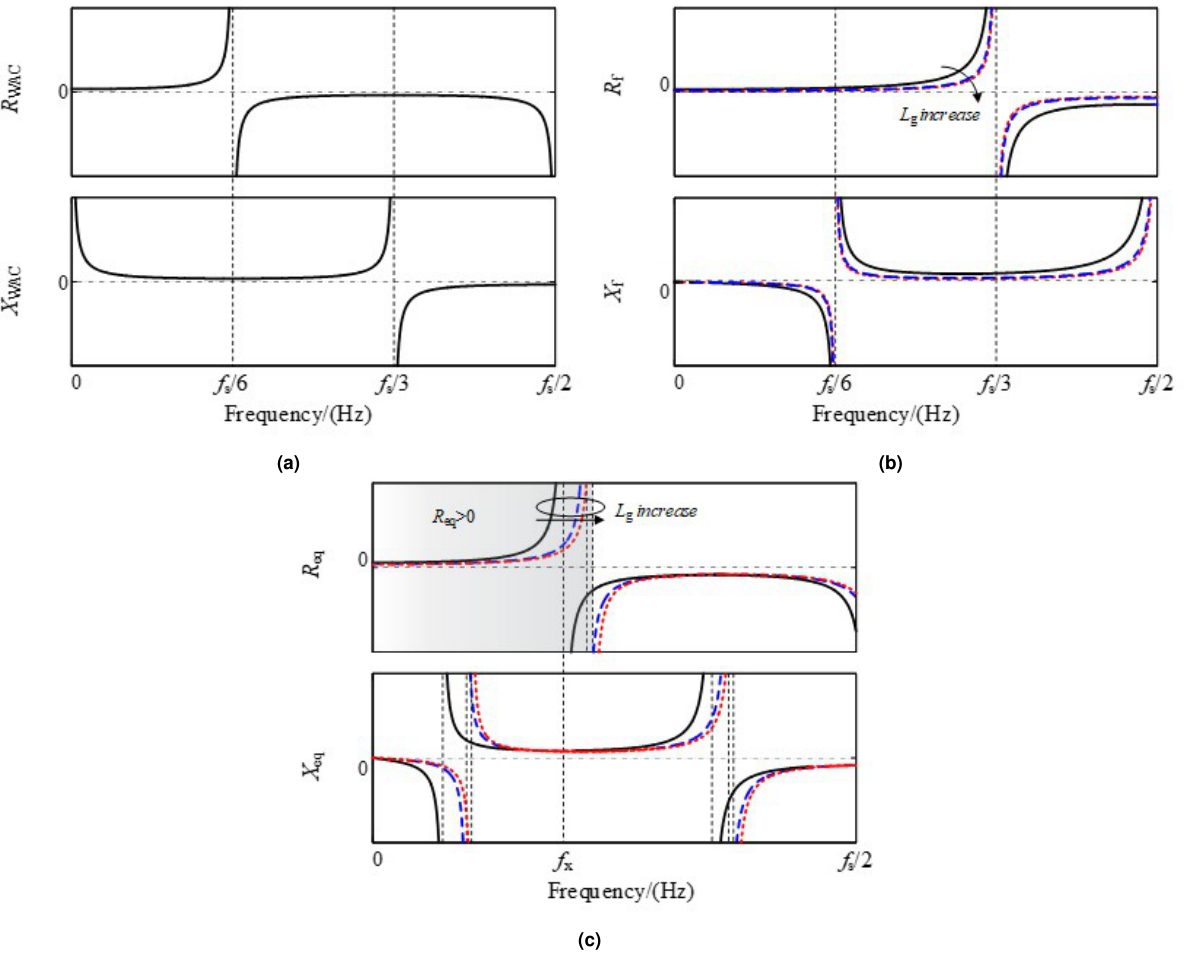
Fig. 6. Frequency characteristic curve of virtual resistance and reactance. (a) Frequency characteristic curve of R WAC and X WAC . (b) Frequency characteristic curve of R f and X f . (c) Frequency characteristic curve of R eq and X eq .